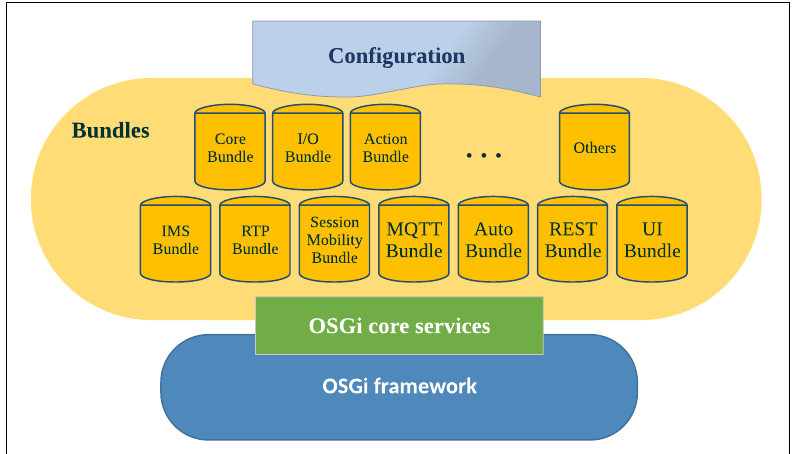
Figure 3. Core architecture of the IMS service proxy